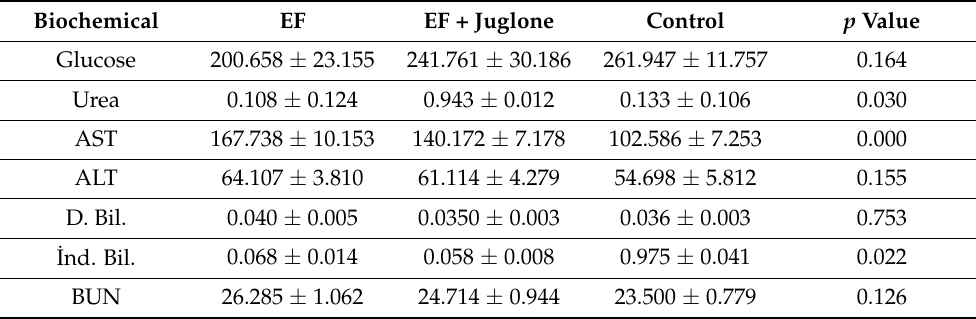
Table 1. Statistical evaluation of the biochemical values of the groups by Tukey test method ( p < 0.05), ( p > 0.05).